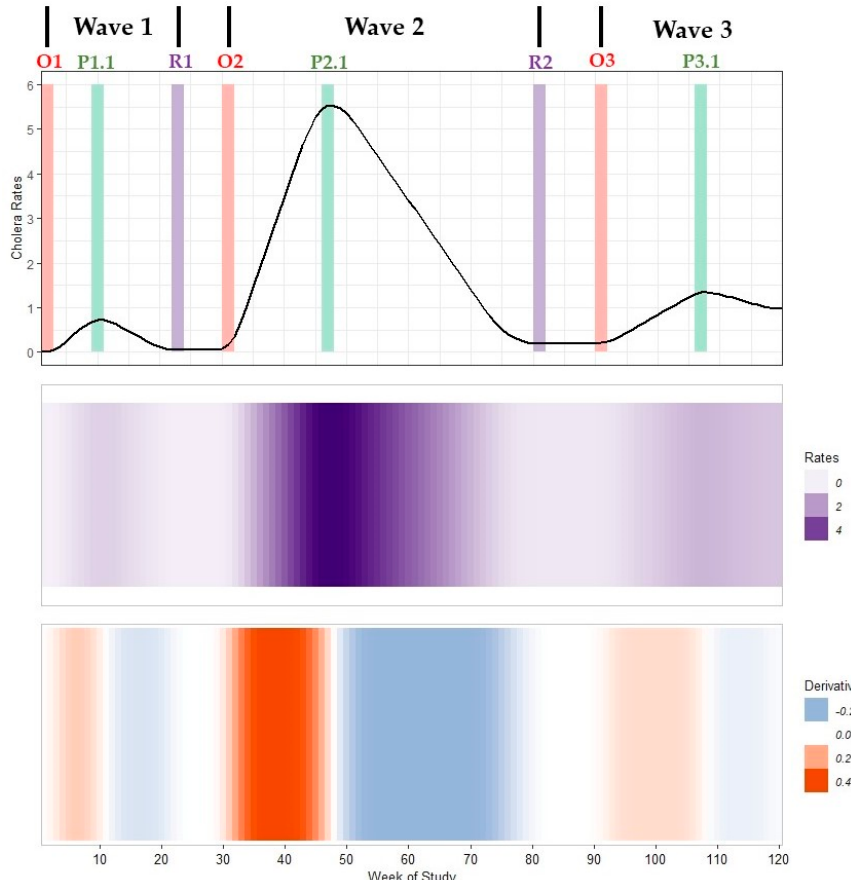
Figure 1. A multi-panel plot of an example cholera outbreak signature with three waves. Top panel: a time series of smoothed average rates of cholera infection (an epidemic curve). Middle panel: a heatmap that compactly reports weekly rates (outbreak magnitude) where light purple represents low values and dark purple represents high values. Bottom panel: a heatmap of the change in rates (trivial derivative) where acceleration periods are shown by the orange gradient, deceleration periods are shown by the blue gradient, and steady-state periods or critical change points near peaks are shown in grey. All panels share the common horizontal axis of time (study week). The timing of outbreak onset ( O n ), peak ( P n.i ), and resolution ( R n ) are marked with red, green and purple bars, respectively, for the n th wave and the i th peak within that wave. If no resolution period occurs, the outbreak remains ongoing until reaching resolution or the next wave’s onset (shown in Wave 3). Data used to develop this visualization are reported in Supplementary Excel Table S2.